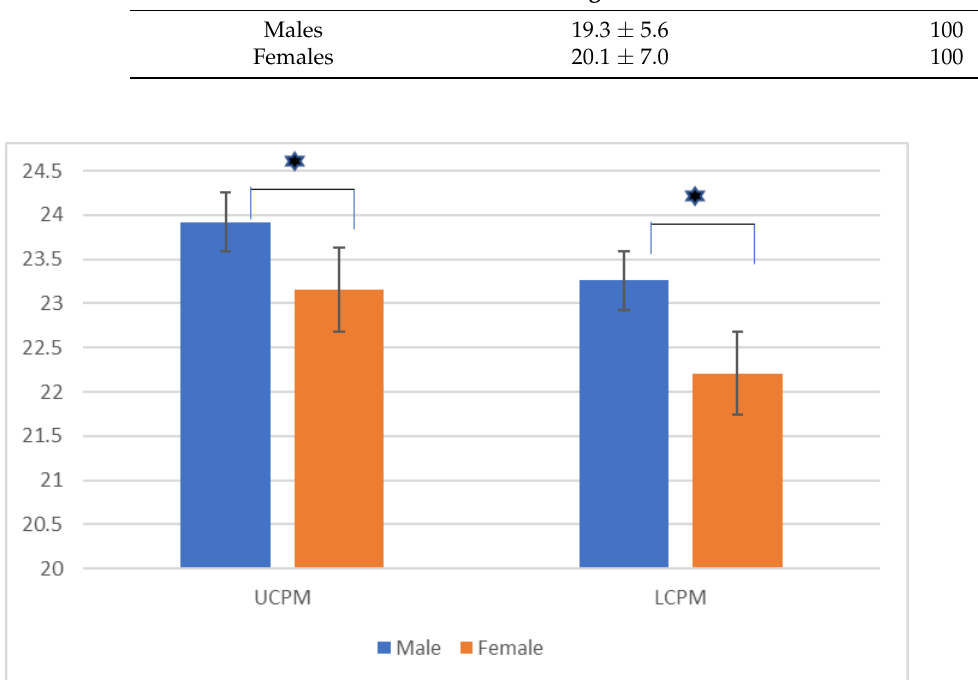
Figure 1. Comparison of tooth sizes between males and females ( = p < 0.05; UCPM = combined mesiodistal width of the upper canines and premolars; LCPM = combined mesiodistal width of the lower canines and premolars).